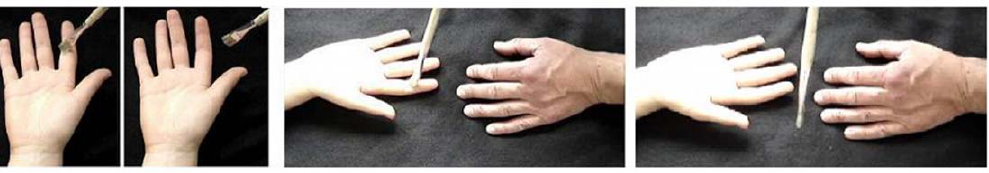
Figure 1. Conditions and types of stimuli used in the first experiment. The two pictures on the left depict the conditions touch hand and movements in peripersonal space, respectively, in 1PP. The two pictures on the right show touch hand and movements in peripersonal space, respectively, in 3PP.